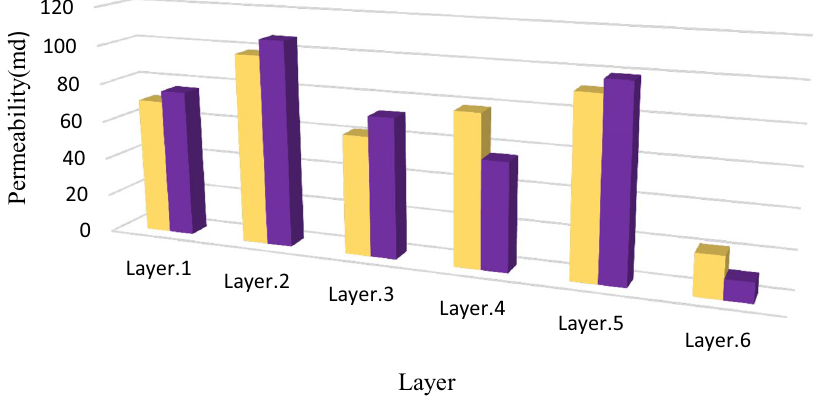
Fig. 8 Comparison of perme- ability between two techniques after correcting core data